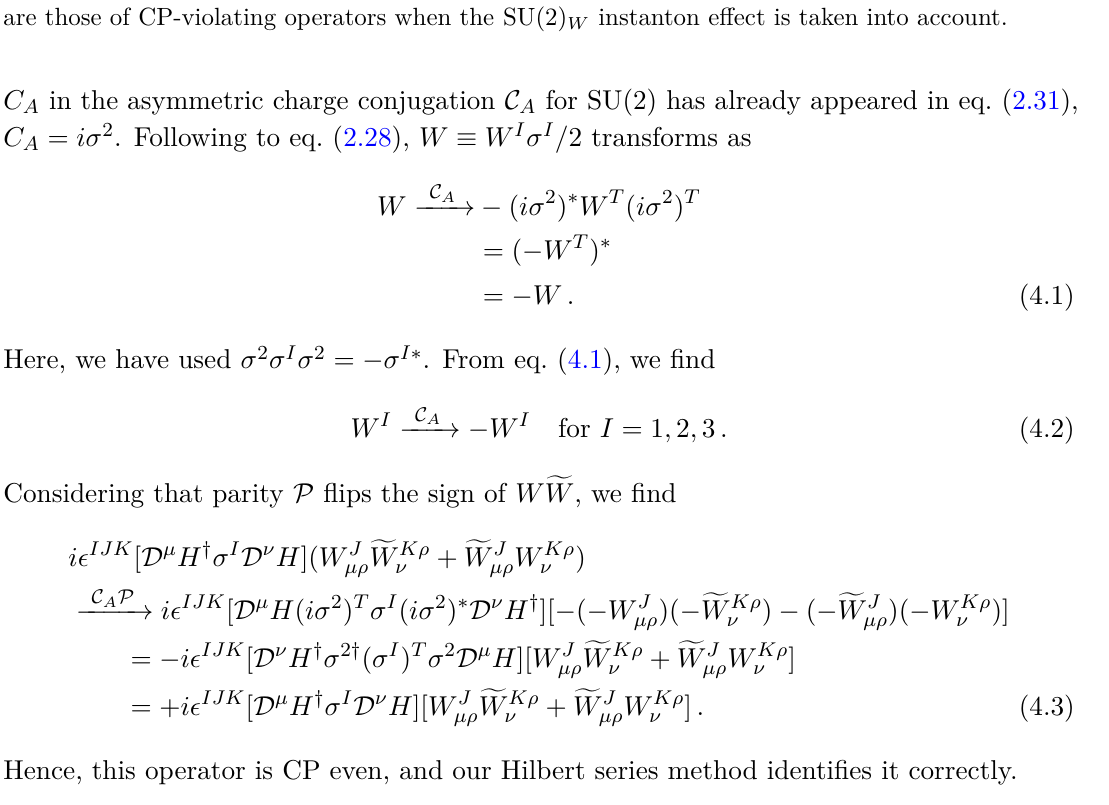
Table 3 . The numbers of CP-odd and CP-violating operators for N f = 1 , 3 , as well as the computing time for N = 3 CP-odd operators on the Apple M1 max with ten cores. The numbers in parentheses f are those of CP-violating operators when the SU(2) instanton effect is taken into W